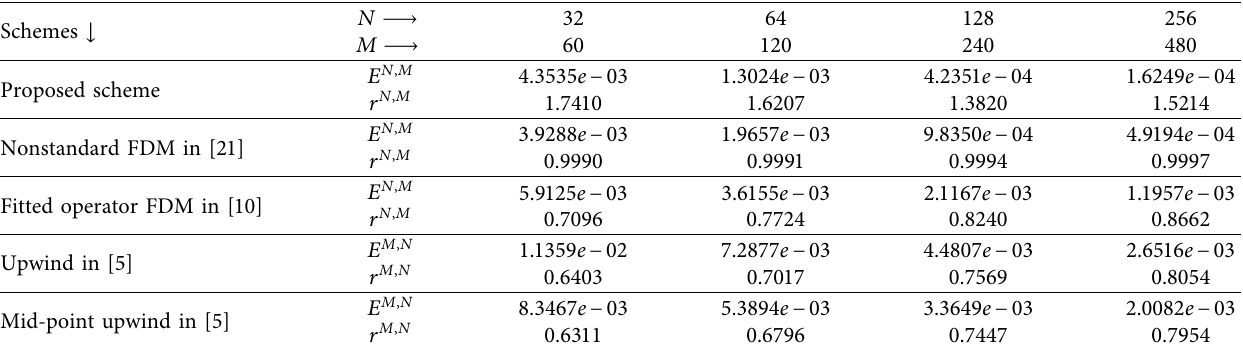
Table 5: ε -Uniform error and ε -uniform rate of convergence of the proposed scheme and results in [5, 10, 21] of Example 2. N Schemes ↓